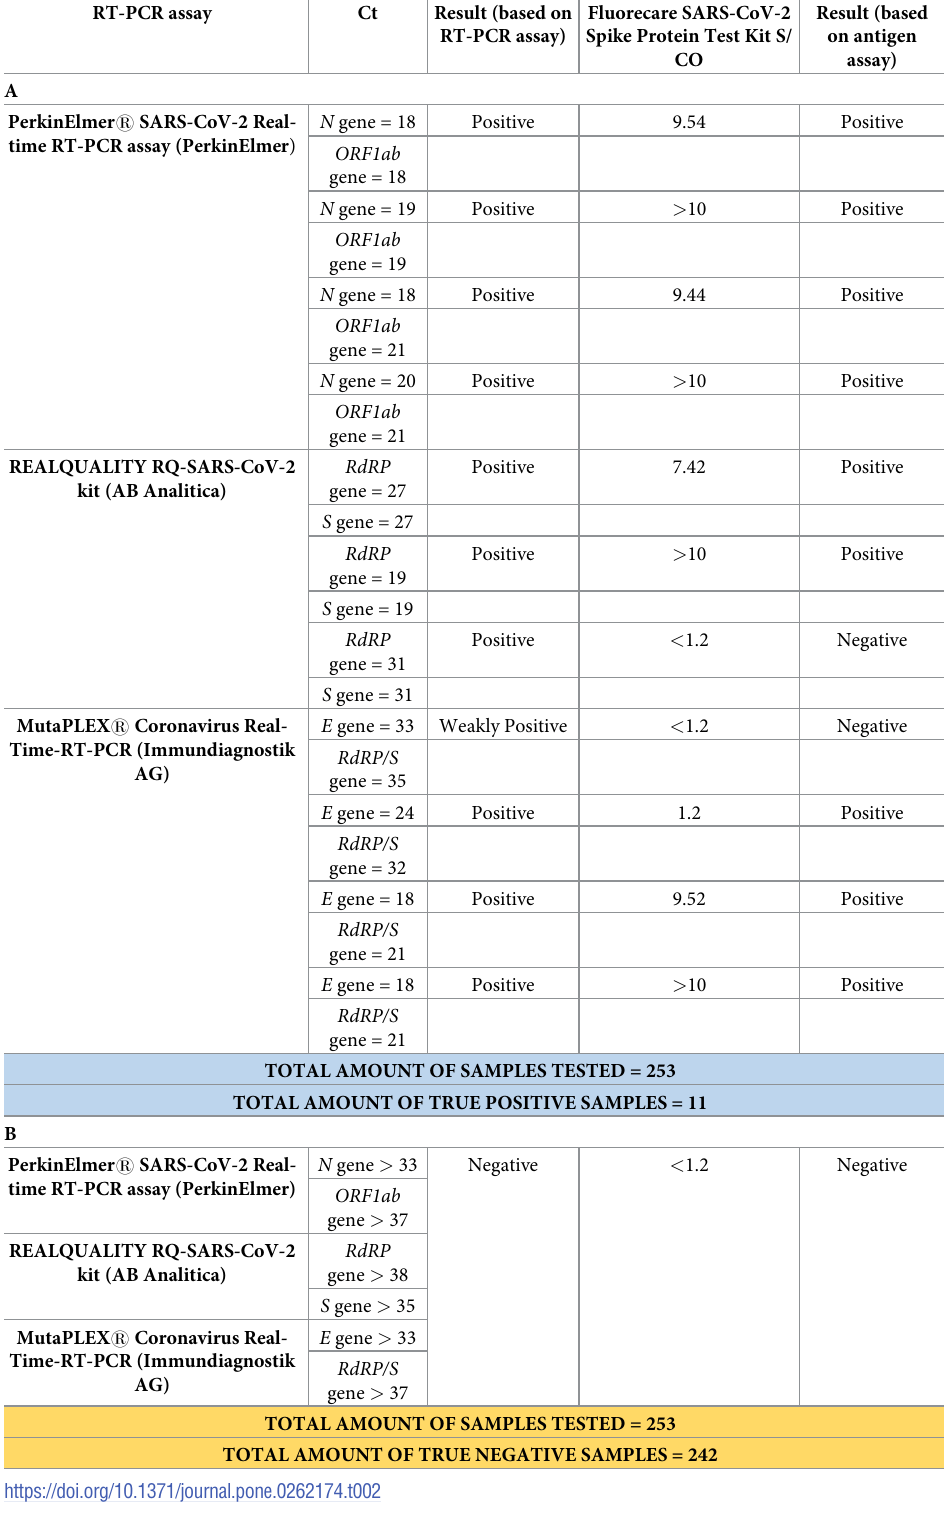
Table 2. RT-PCR Ct values and Fluorecare SARS-CoV-2 Spike Protein Test Kit S/CO values in positive (A) and negative (B)